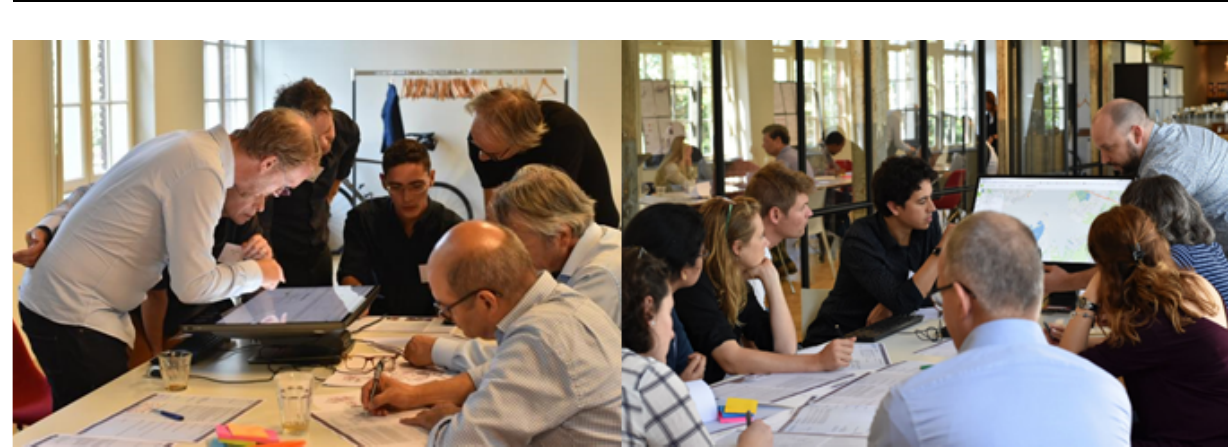
Figure 6. Use of touch tables at GDSE workshop sessions in horizontal (left) or vertical mode (right). Photos: author Marcin